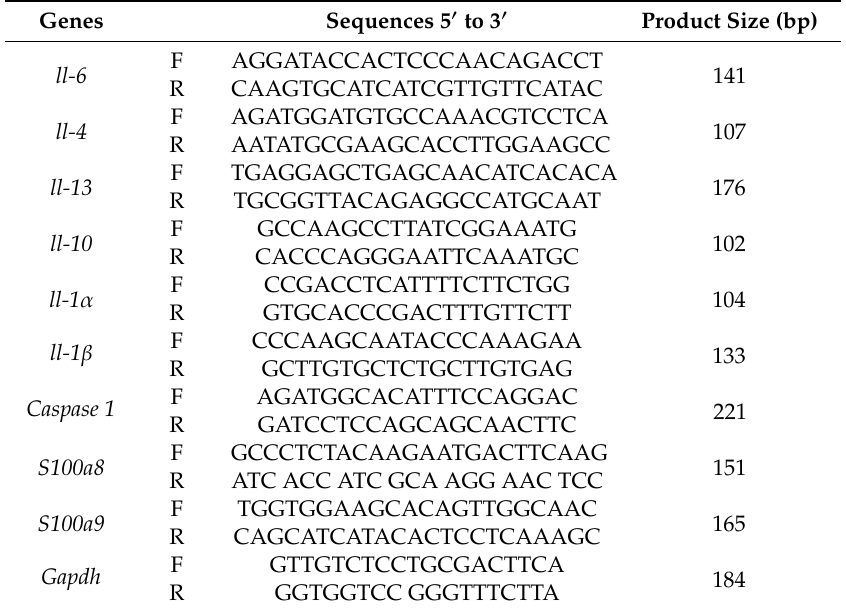
Table 1. Primer sequences used for